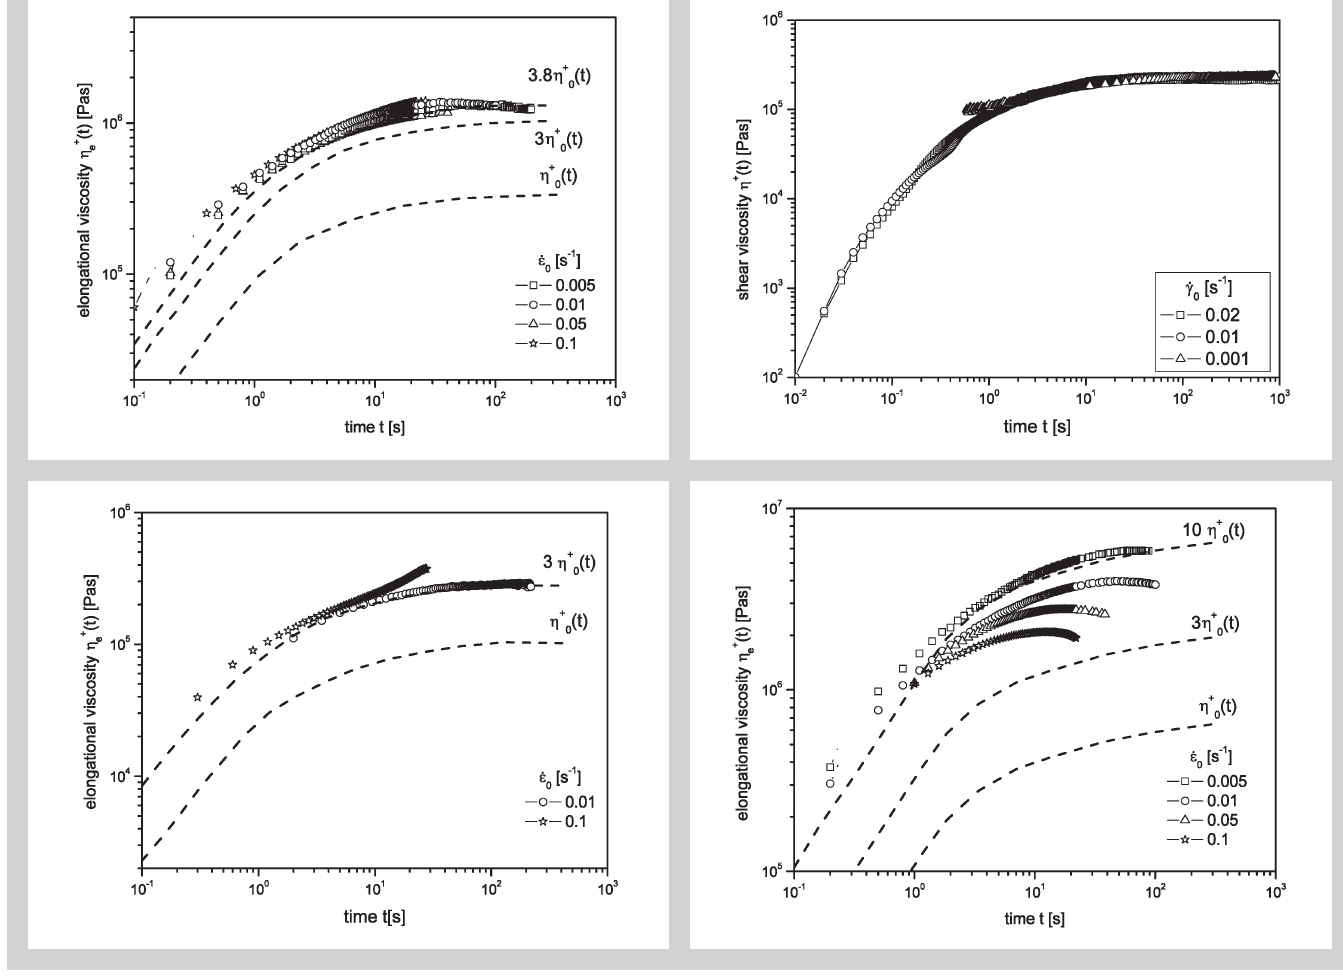
Figure 8 (left above): Transient elongational and shear viscosity of PMMA at 180°C. Figure 9 (right above): Stressing experiments of PMMA at different shear rates at 180°C. Figure 10 (left below): Transient elongational and shear viscosity of PS at 180°C. Figure 11 (right below): Transient elongational and shear viscosity of PMMA / 8.9 vol% nano-clay at